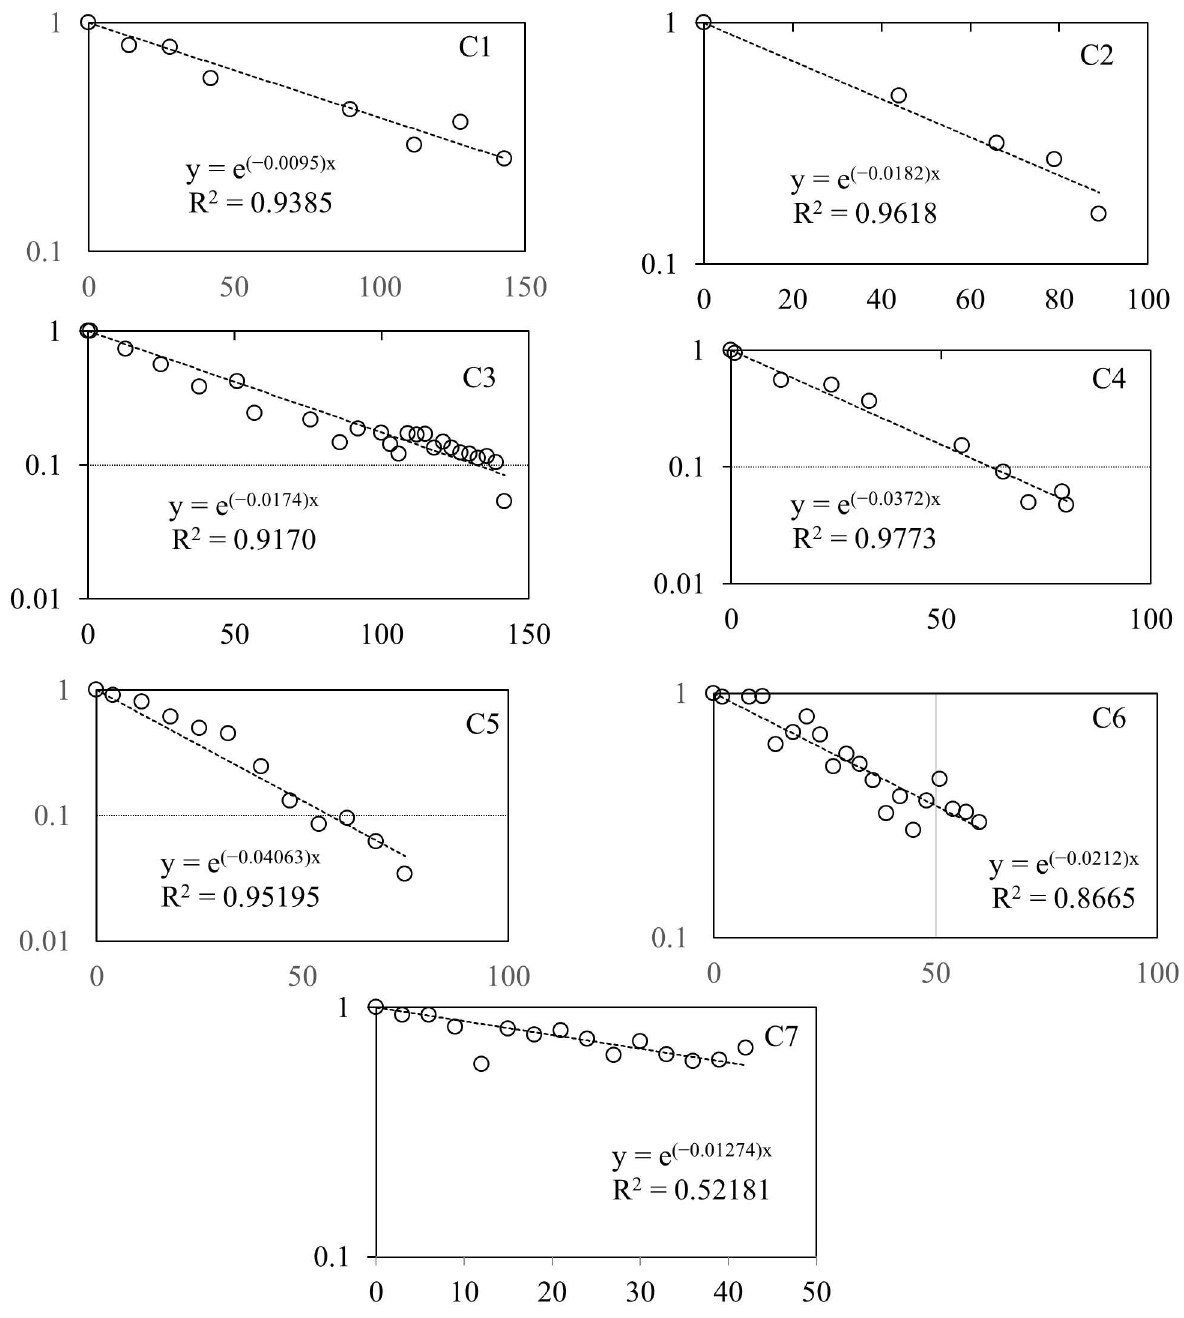
Fig 3. The decay curves of radiocesium ( 137 Cs) in canine bodies. The graph shows the relativeconcentration in the wholebody versus the number of days elapsedsince the first measurement date. Each regression equationand the coefficient of determinationare